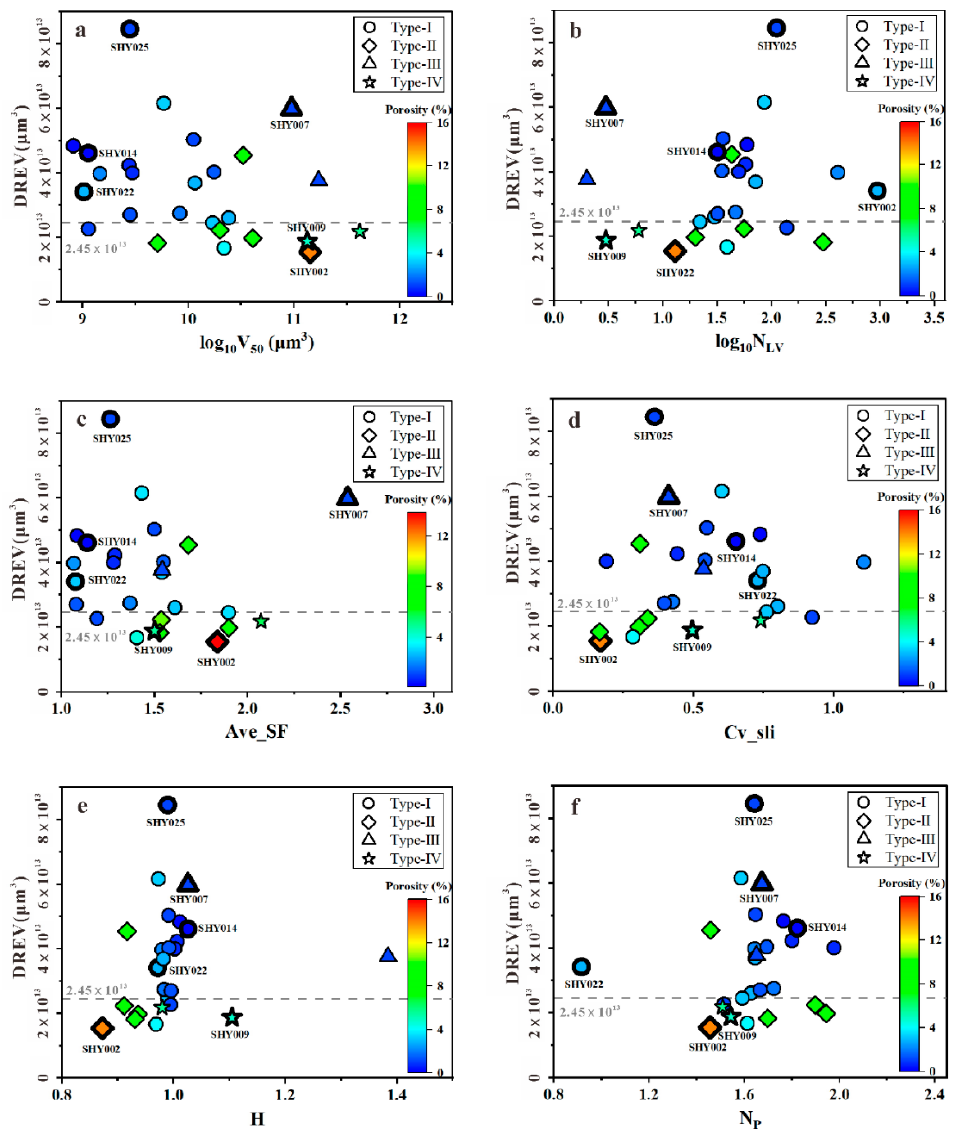
Figure 16. Cross ‐ plots of DREV and five parameters with porosity superimposed in color. Marker shape represents pore type. ( a ) DREV versus log 10 V 50 . ( b ) DREV versus log 10 N LV . ( c ) DREV versus Ave_SF . ( d ) DREV versus Cv_sli. ( e ) DREV versus H . ( f ) DREV versus N p